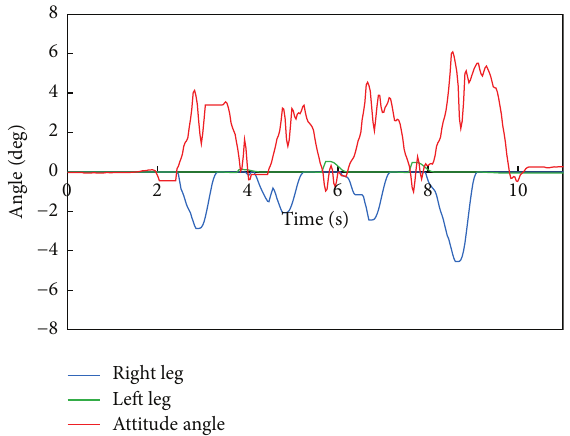
Figure 7: WABIAN-2R’s attitude angle and the modification angle of a swing foot about the roll axis with 90 mm breadth feet.